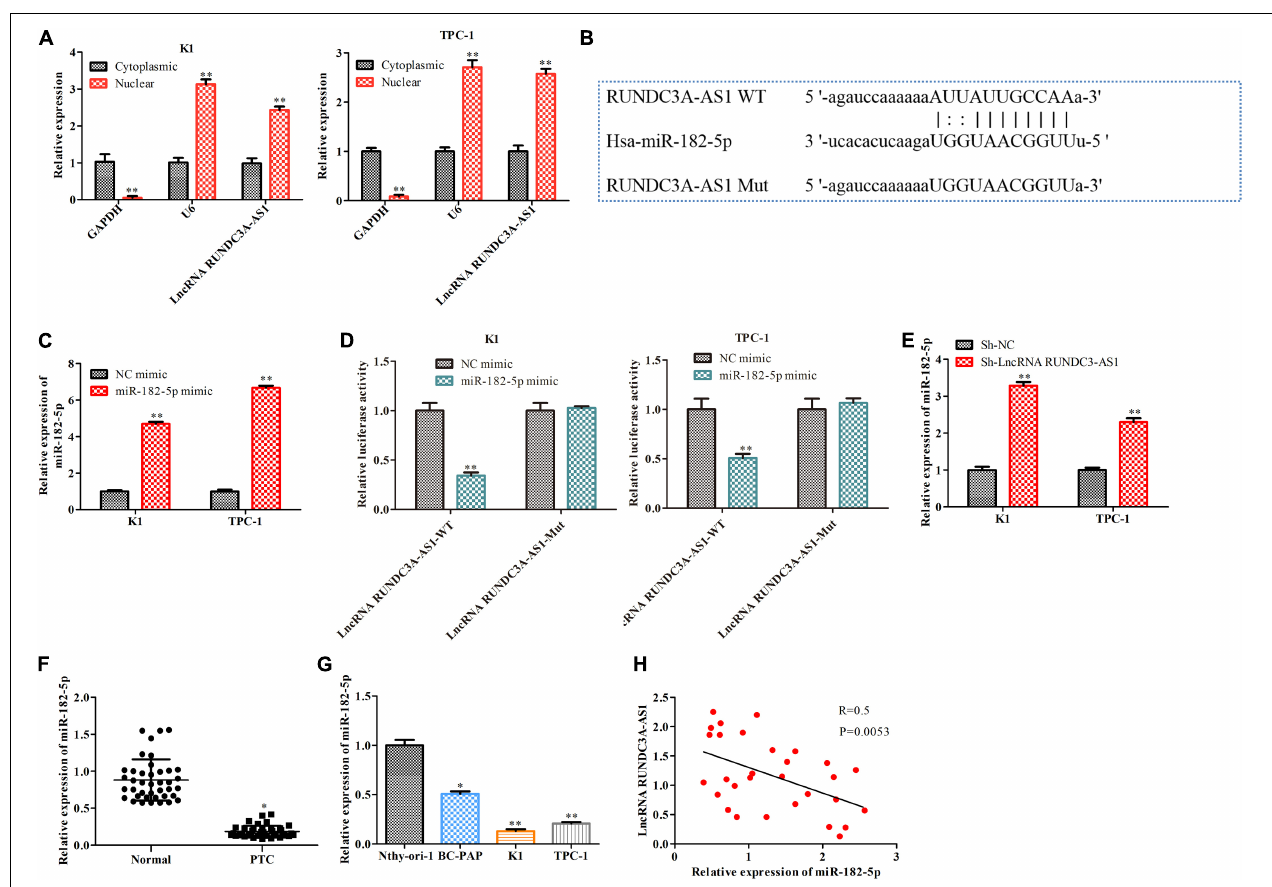
FIGURE 3 | RUNDC3A-AS1 directly binds to miR-182-5p and downregulates the expression of miR-182-5p. (A) The expression level of RUNDC3A-AS1 in nucleus and cytoplasm was analyzed by RT-qPCR. ** P < 0.01 vs. the Cytoplasmic group. (B) The predicted RUNDC3A-AS1 binding sites in the region of miR-182-5p and the corresponding mutant sequence were shown. ** P < 0.01 vs. the Cytoplasmic group. (C) The relationship level of miR-182-5p both in K1 and TPC-1 cells after transfected with NC mimic and miR-182-5p mimic, respectively. (D) Relative values of luciferase signal. * P < 0.05, ** P < 0.01 vs. the NC mimic group. (E) The expression level of miR-182-5p both in K1 and TPC-1 cells after transfected with sh-NC and RUNDC3A-AS1 shRNAs, respectively. ** P < 0.01 vs. the sh-NC group. (F) The expression level of miR-182-5p in tumor and para-carcinoma tissues. * P < 0.05 vs. the normal group. (G) The expression level of miR-182-5p in normal thyroid cells and thyroid cancer cell lines. * P < 0.05, ** P < 0.01 vs. the Nthy-ori3-1 cell line. (H) A negative correction between lncRNA RUNDC3A-AS1 and miR-182-5p expression. The data were presented as mean ± SD and the experiments were repeated 3